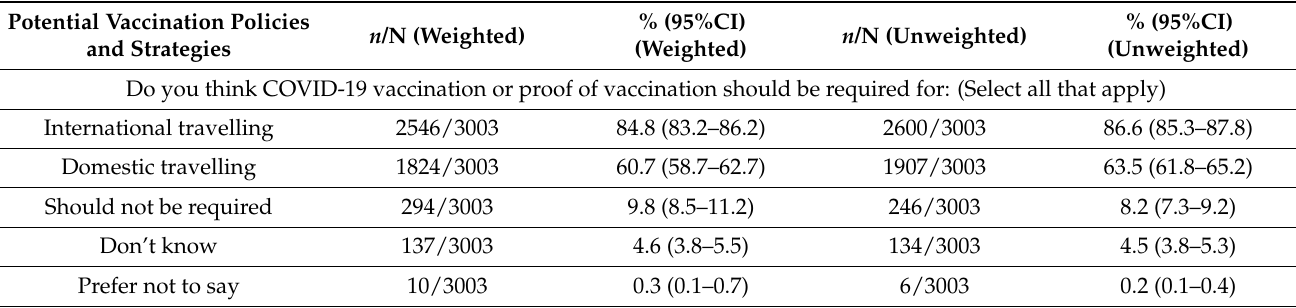
Table 5. Descriptive statistics of respondents who supported potential vaccination policies and strategies. Potential Vaccination